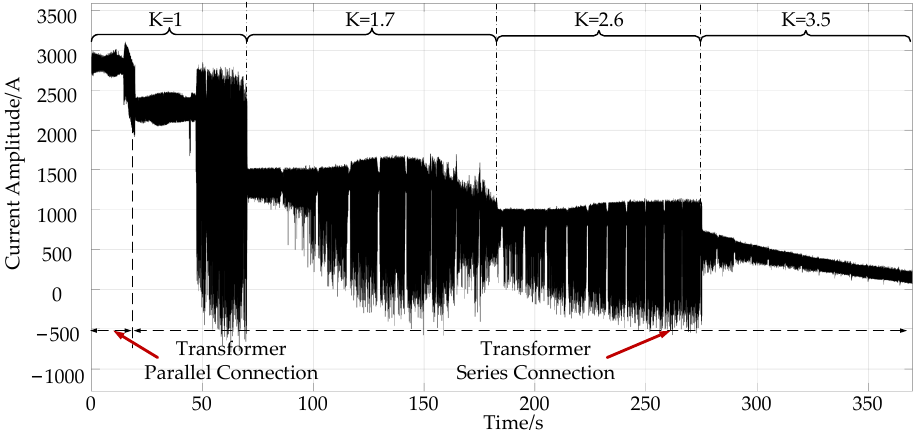
Figure 18. The q -axis output current of the converter at the start points.